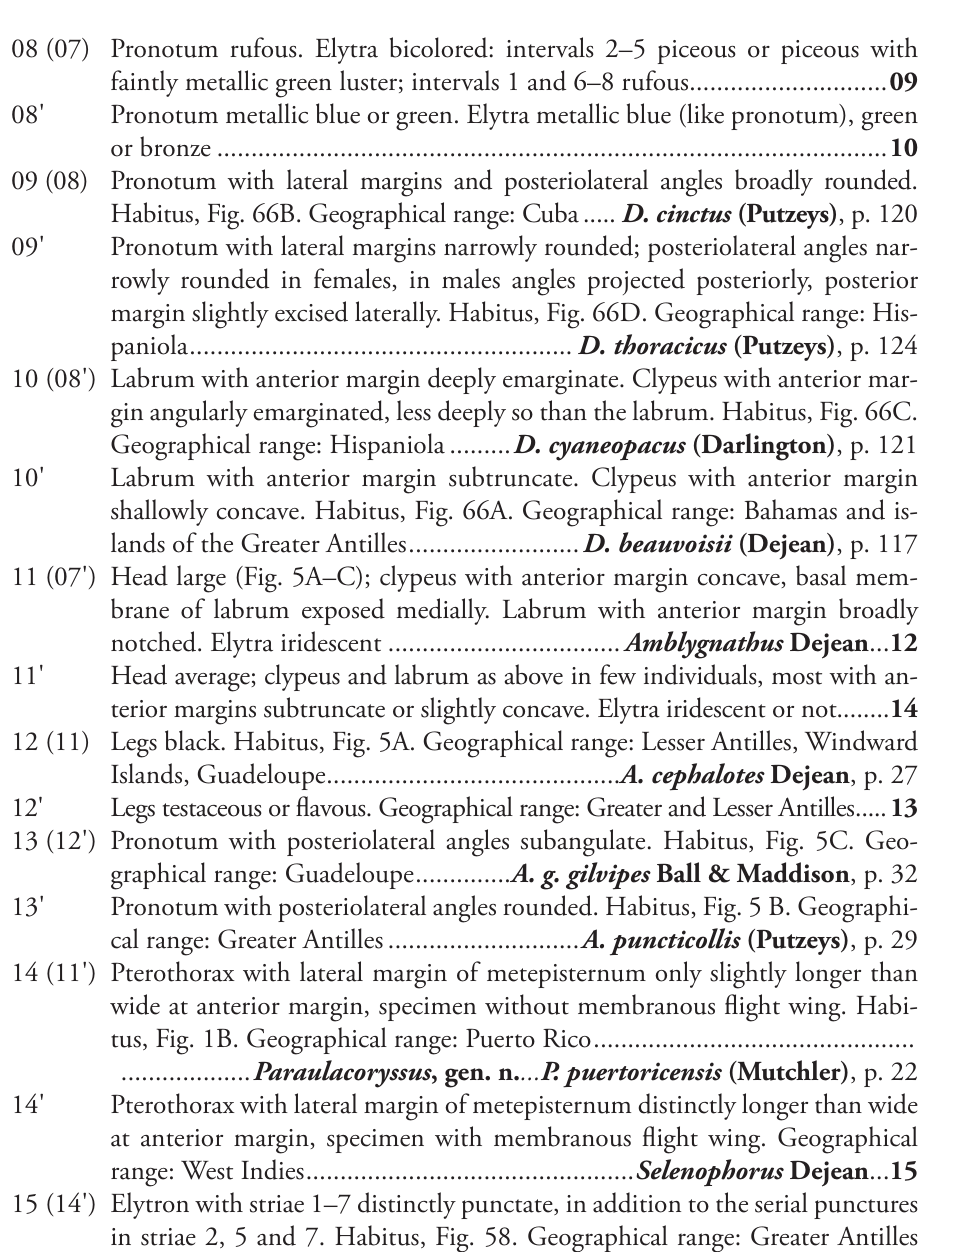
Pterothorax with lateral margin of metepisternum distinctly longer than wide at anterior margin, specimen with membranous flight wing.